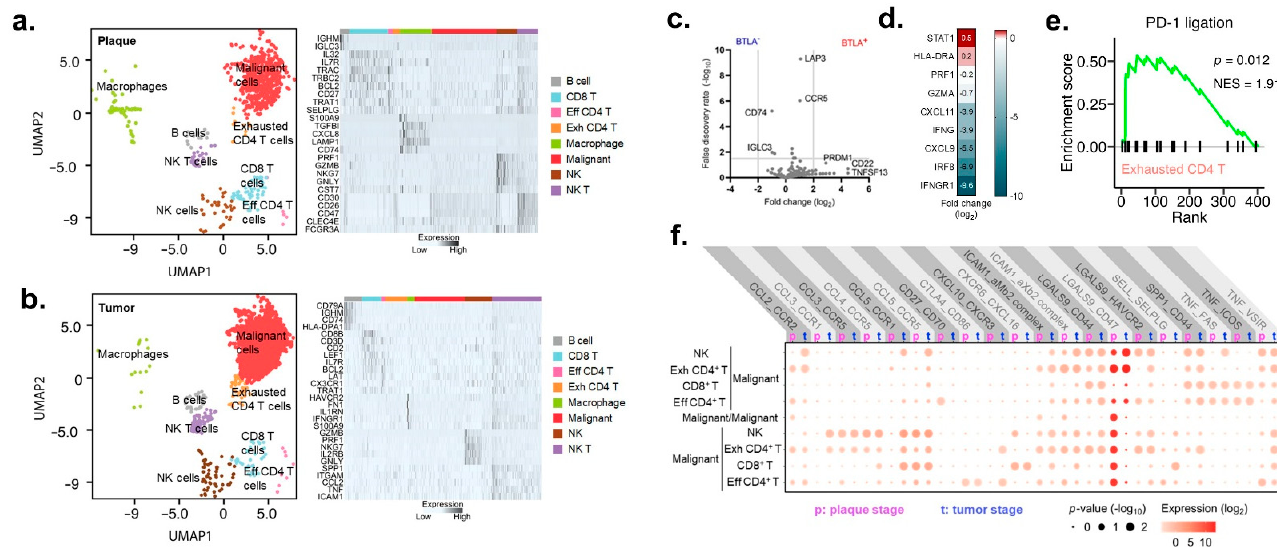
Figure 3. Intercellular interactions between malignant cells and TILs. ( a ) UMAP projection of single-cell RNA sequencing from a patient with plaque-stage mycosis (left). Heat map showing relative expression ( z -score) of selected genes for cells identified in subfigure ( a ) (right). ( b ) UMAP projection of single-cell RNA sequencing from three patients with tumor-stage mycosis (left). Heat map showing relative expression ( z -score) of selected genes for cells identified in subfigure ( b ) (right). ( c ) Volcano plot illustrating differential tissue gene expression from BTLA − or BTLA + non-malignant CD4 + T cells. ( d ) Changes in IFN- γ genes in exhausted CD4 + T cells in comparison with non-exhausted CD4 T-cells. ( e ) Enrichment plots of gene set enrichment analysis for the gene expression profile of exhausted CD4 + T cells using PD-1 ligation gene set. ( f ) Intercellular CellPhoneDB analysis illustrating shifts in expression of the indicated ligand-receptor complexes for malig- nant cells between plaque and tumor stage MF.